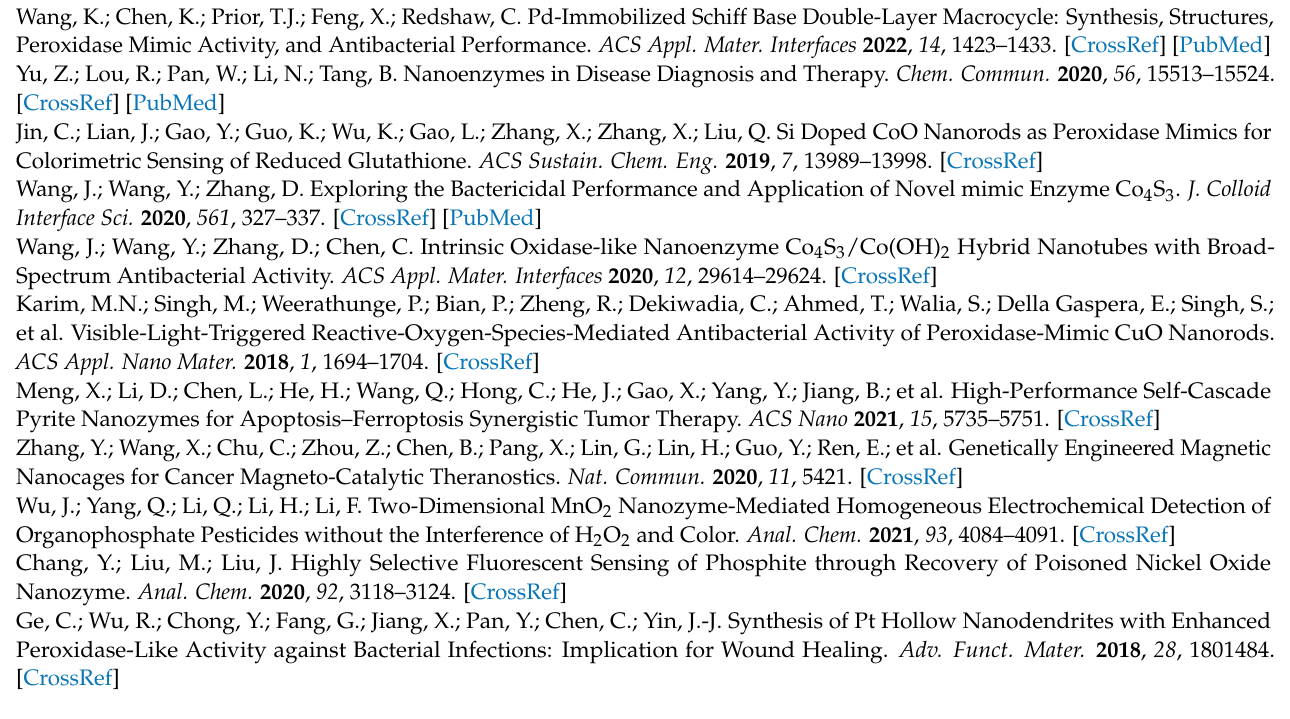
catalytic activity for five cyclic experiments; Figure S6. The SEM image of Ni 0.1 Cu 0.9 S nanozyme after the stability test; Figure S7. (a) and (b) the Michaelis–Menten curve for H 2 O 2 and TMB, respectively. (c) and (d) the Lineweaver–Burk plot for determination of kinetic constant of Ni 0.1 Cu 0.9 S nanoflower for H 2 O 2 and TMB, respectively; Figure S8. Relative OD 600 values of Ni 0.1 Cu 0.9 S nanozyme towards E. coli and S. aureus ; Figure S9. The release curve of time-dependent Cu 2+ of Ni 0.1 Cu 0.9 S nanozyme in test system plotted with data obtained by ICP; Figure S10. Survival rates of E. coli and S. aureus treated with Cu 2+ supernatant samples. Table S1. Summary of ICP-OES results for Ni 0.1 Cu 0.9 S nanoflower; Table S2. Comparison of the K m and V max values for Ni 0.1 Cu 0.9 S nanoflower with those of other peroxidase mimicase; Table S3. The ICP-OES results of cumulative Cu 2+ release from Ni 0.1 Cu 0.9 S nanozyme in test system; Table S4. Comparison of different sensors for AA detection; Table S5. Determination of the amounts of AA in real samples (n=3)